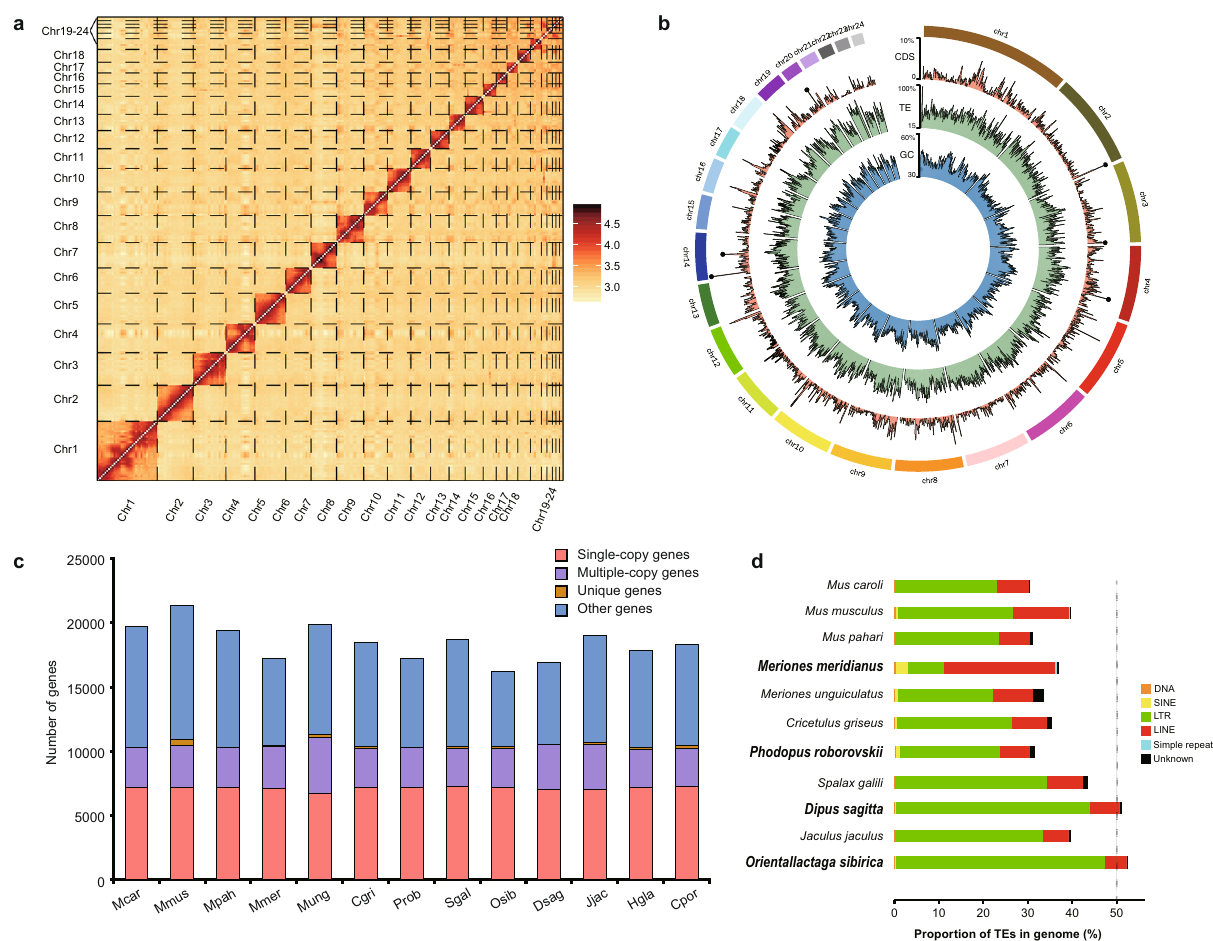
Fig. 2 High-quality assembly of Dipus sagitta genome and genomic elements of the four sequenced desert rodents. a Hi-C heat map of Dipus sagitta genome assembly. b CIRCOS plot showing the distribution of GC content, transposable elements (TE), and coding sequences (CDS) in the D. sagitta genome. c Orthologous coding sequences composition inferred for thirteen rodents ’ genomes. Mcar Mus caroli , Mmus Mus musculus , Mpah Mus Pahari , Mmer Meriones meridianus , Mung Meriones unguiculatus , Cgri Cricetulus griseus , Prob Phodopus roborovskii , Sgal Spalax galili , Osib Orientallactaga sibirica , Dsag Dipus sagitta , Jjac Jaculus jaculus , Hgla Heterocephalus glaber , Cpor Cavia porcellus . d Proportion of transposable elements (TEs). The barplots show the proportions of different types of TEs in corresponding species on the phylogenetic